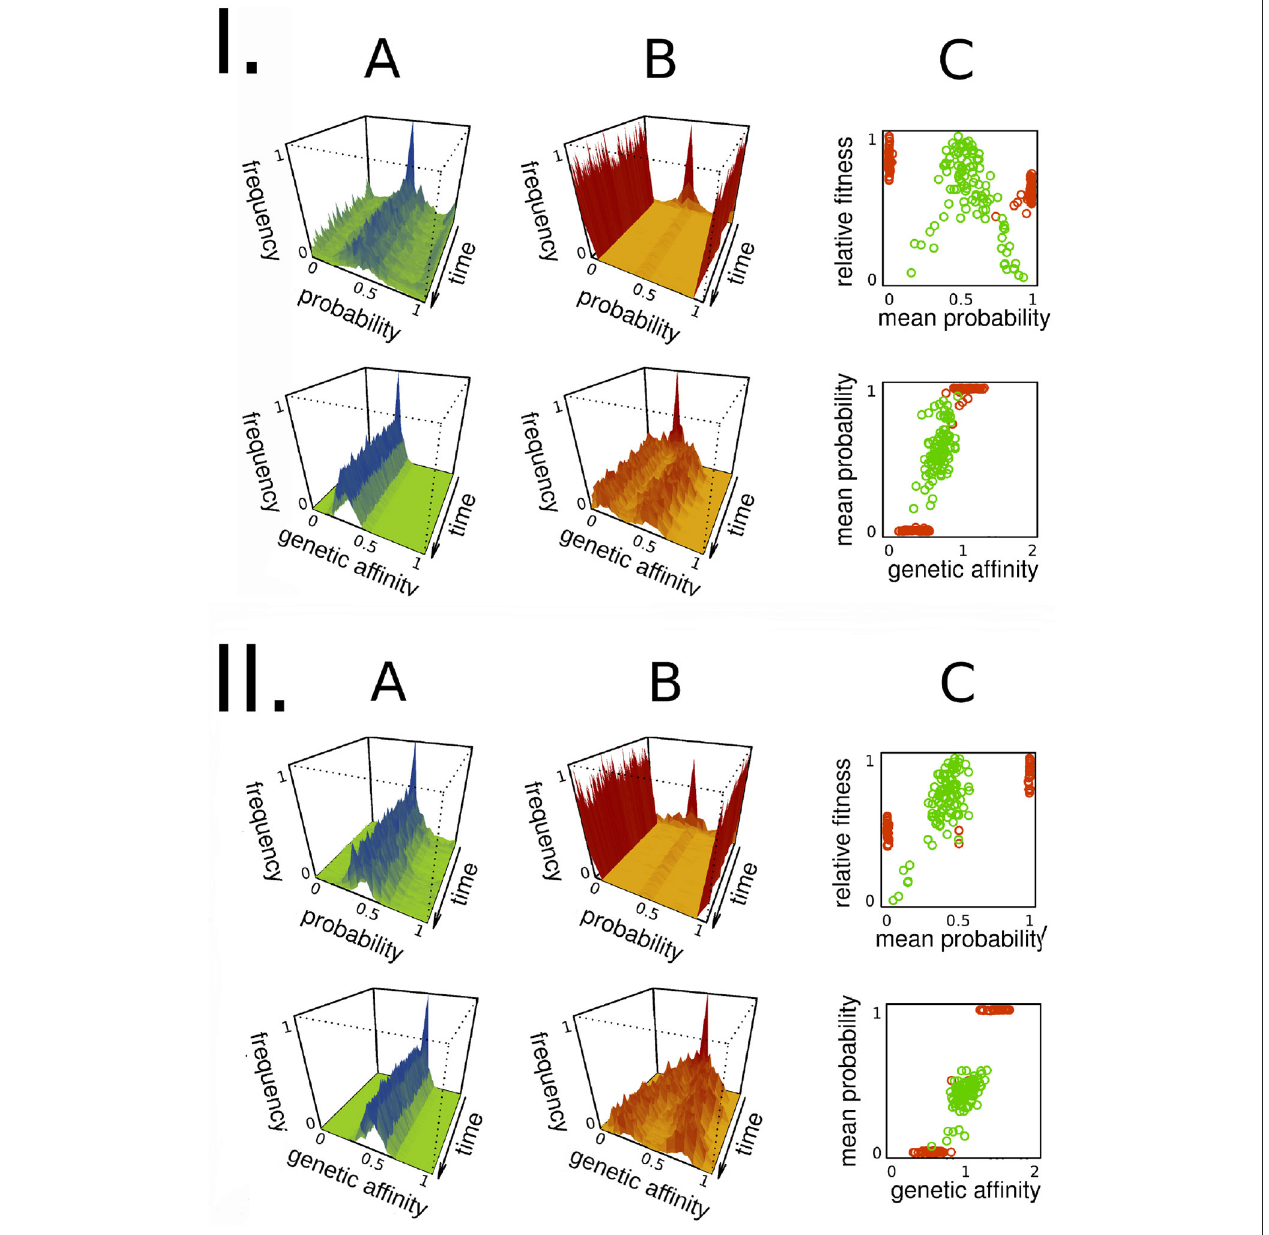
FIGURE 3 | Summary of the basic results in both settings with stronger (I) and weaker (II) trade-offs. The figure shows the task choice probabilities (top row) and the distribution of the genetics (bottom row) for one task throughout all generations. The top right plots show the fitness of individuals as a function of their average life-long task choice probabilities. The bottom right plots show these average probabilities as function of the genetic affinity assigned to the same task. The greenish colors ( A columns) represent the subsistence, the reddish ( B columns) the producer case. For the parameters see Table 1 .